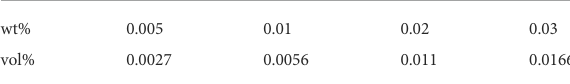
TABLE 2 Conversion of mass fraction to volume